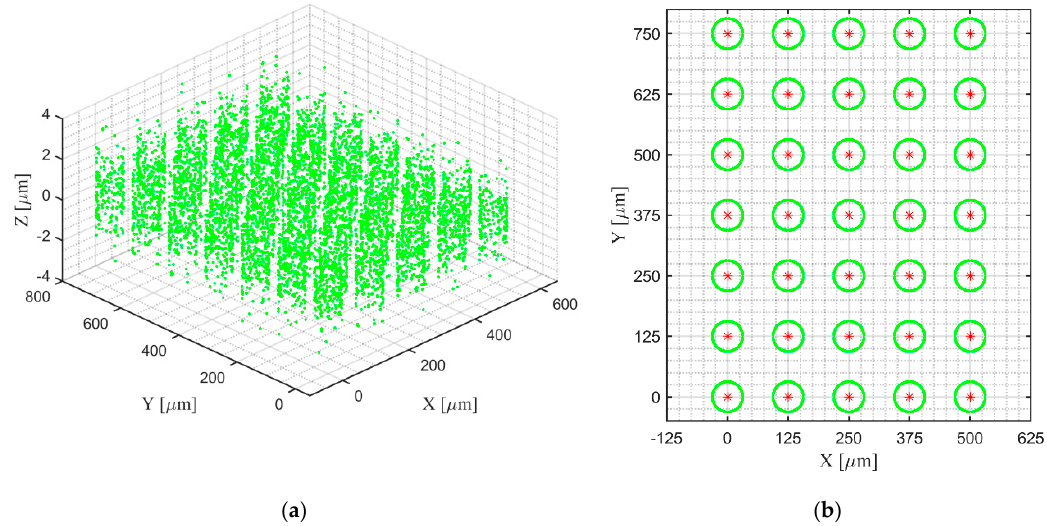
Figure 11. Plot of the created data for algorithm validation: ( a ) 3D view of the point cloud; ( b ) view from the Z ‐ axis.